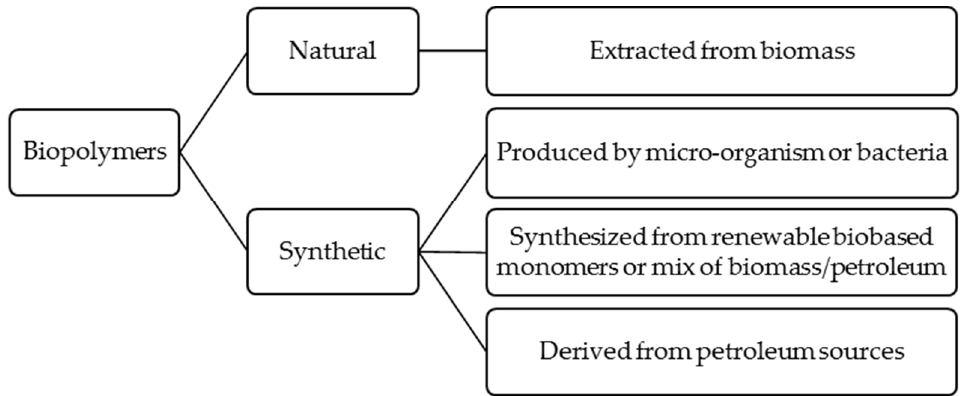
Figure 1. Origins of biopolymer materials [©MB, JA, MAM_UC3M2020].